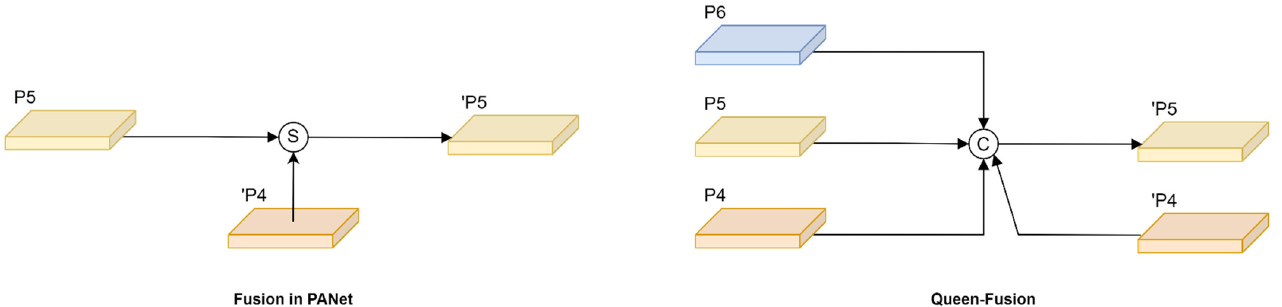
Figure 6. The improved design of cross-scale connection structure. S and C refer to the summation and concatenation, respectively. ‘P k refers to the node at the next